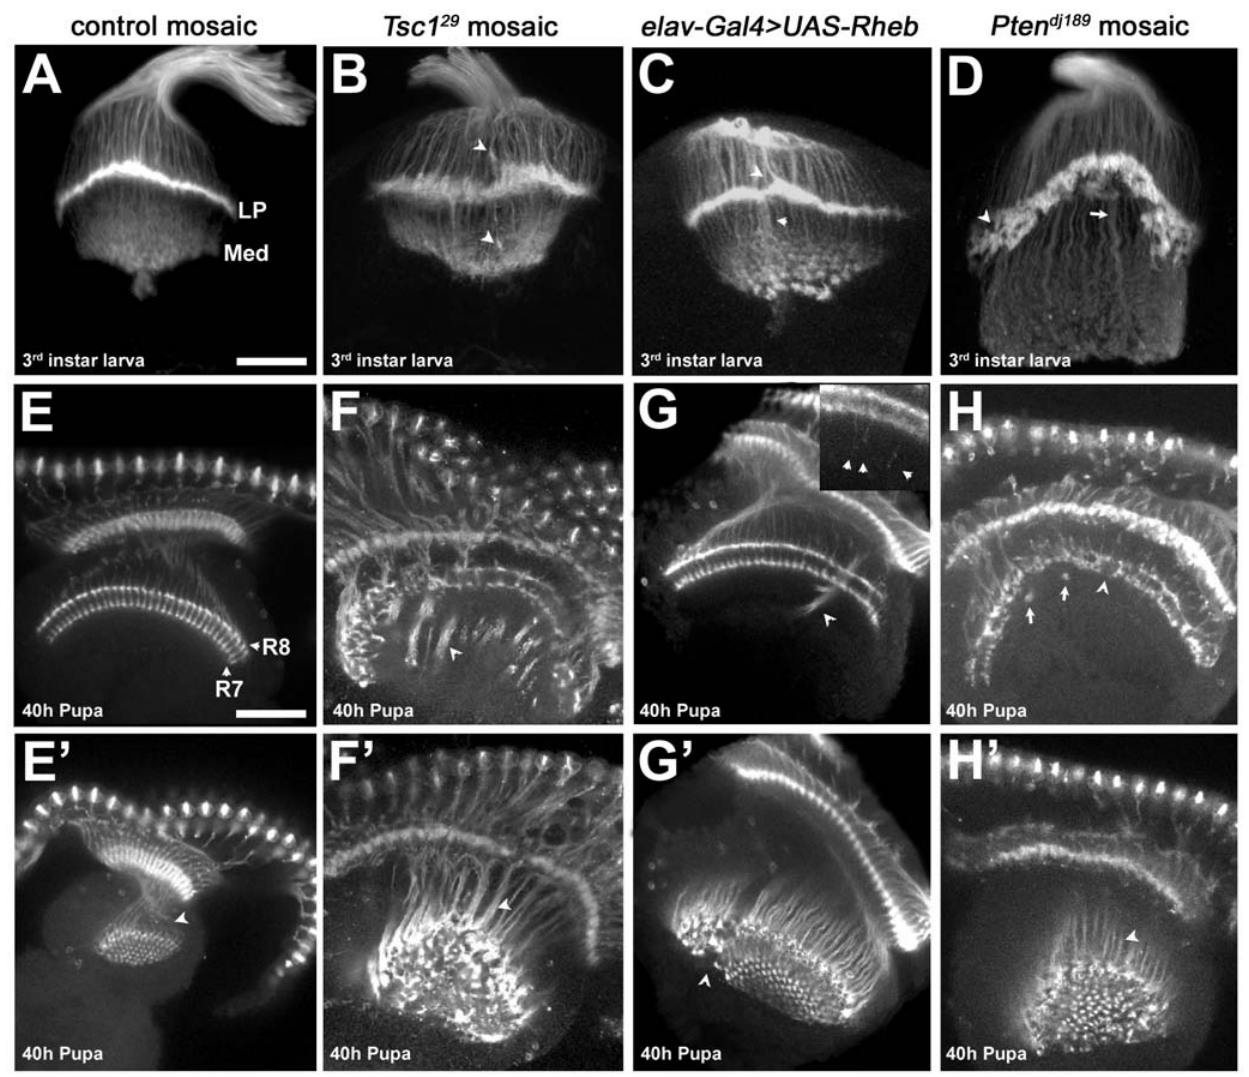
Figure 5. Photoreceptor axon projection defects associated with increased Tor signaling. (A–D) Dorsal-posterior views of third instar optic lobes stained with MAb24B10 to visualize photoreceptor projections. (A) Mitotic clones in an FRT82B control background show proper termination of photoreceptor axons R1-6 at the lamina plexus (LP), and termination of photoreceptors R7 and R8 in the medulla (Med). (B) Tsc1 29 mutant axons terminate at incorrect positions above and below the lamina (arrowheads) and produce a broadened lamina plexus. (C) Neuronal expression of Rheb creates axon termination defects similar to those seen in Tsc1 mosaics (D) Pten dj189 mutant photoreceptors leave gaps and holes (arrowhead) in the lamina plexus, which is broader and noticeably ‘‘peaked.’’ The medulla contains axon projections which are thicker and much longer than in controls (arrow). (E–H 9 ) Dorsal view of optic lobes from 40h pupae stained with MAb24B10. E 9 –H 9 are lower optical planes of the optic lobes shown in E–H, respectively. (E, E 9 ) Control photoreceptors R7 and R8 show two distinct layers of termination in the medulla (labels), and are arranged in a highly regular pattern (arrowhead). (F) Animals with Tsc1 29 mutant photoreceptors show severe disruption of the R7 and R8 termination layers. Instead of terminating at the correct positions, the axons fail to de-fasciculate, forming dense bundles (arrowheads) that project beyond the medulla. (G, G 9 ) Neuron-directed expression of Rheb causes axon bundles to project beyond the medulla in a fashion similar to Tsc1 mosaics (arrowheads), but the phenotype is much less severe. (G, inset) Individual Rheb-overexpressing axons show an intermediate termination defect, stopping several microns beyond their normal targets (arrowheads in inset). (H) Pten dj189 mutant axons exhibit gaps and collapses in the R7/R8 termination zone (arrowhead). Thick axon bundles can be seen that bypass their usual stopping points and then loop back to terminate at other locations in the R7/R8 layers (arrows). (H 9 , F 9 ) Axon bundles in Pten dj189 mosaics are not as densely packed as those of Tsc1 29 mosaics (arrowheads), but are still disorganized. All scale bars are 50